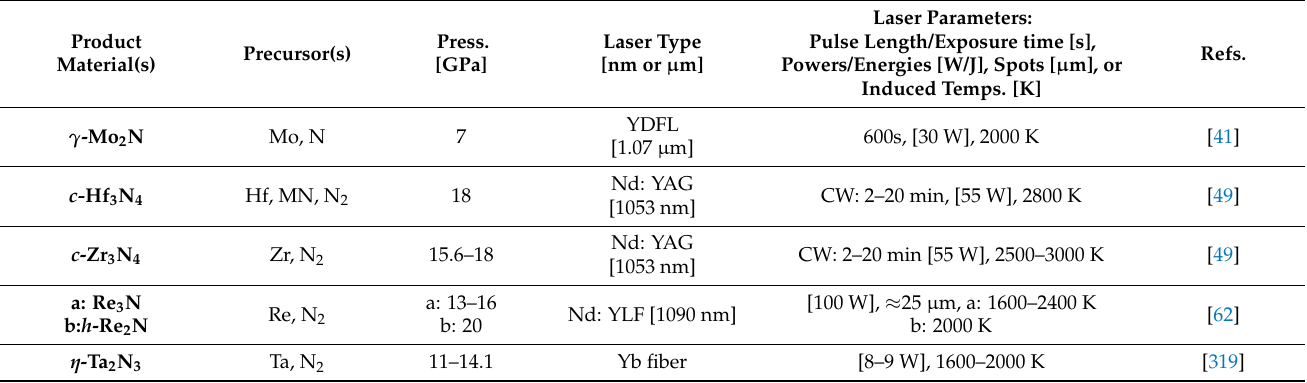
Table 7. Binary Refractory Metal Nitrides: Refractory Metal Nitrides Synthesised During Selected LRS-DAC